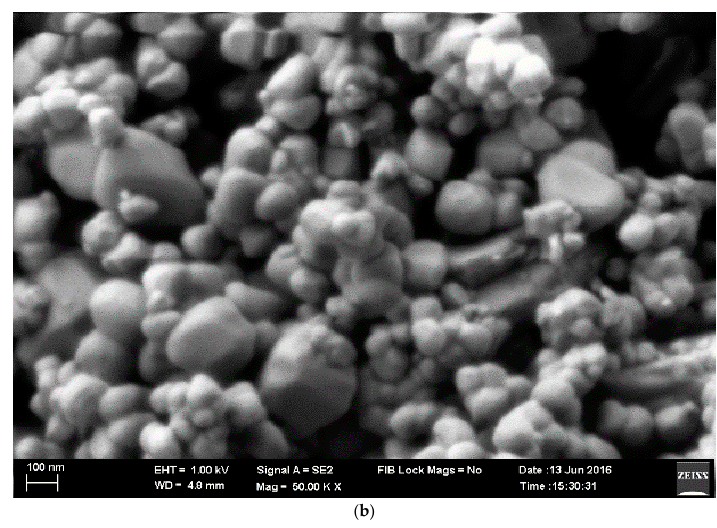
Figure 3. Surface characteristics of ( a ) sodium titanate (Na 2 TiO 3 ) sheets; ( b ) PbZn 0.3 Ti 0.7 O 3 nanoparticles.